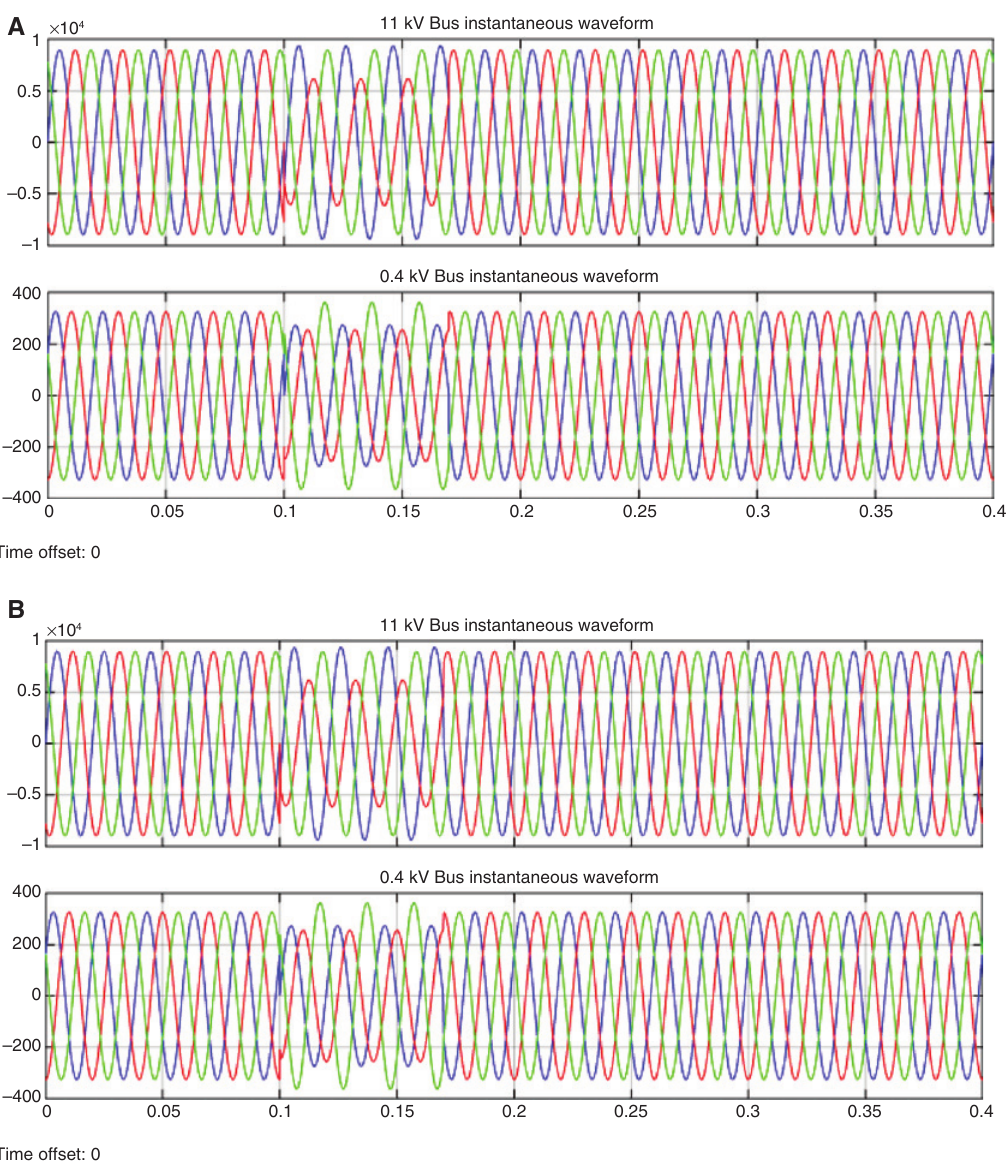
Figure 7: Generation of Fault from Simulation Process at Load at Two Different Loading Conditions: (A) 10 × 10 3 and (B) 20 × 10 3